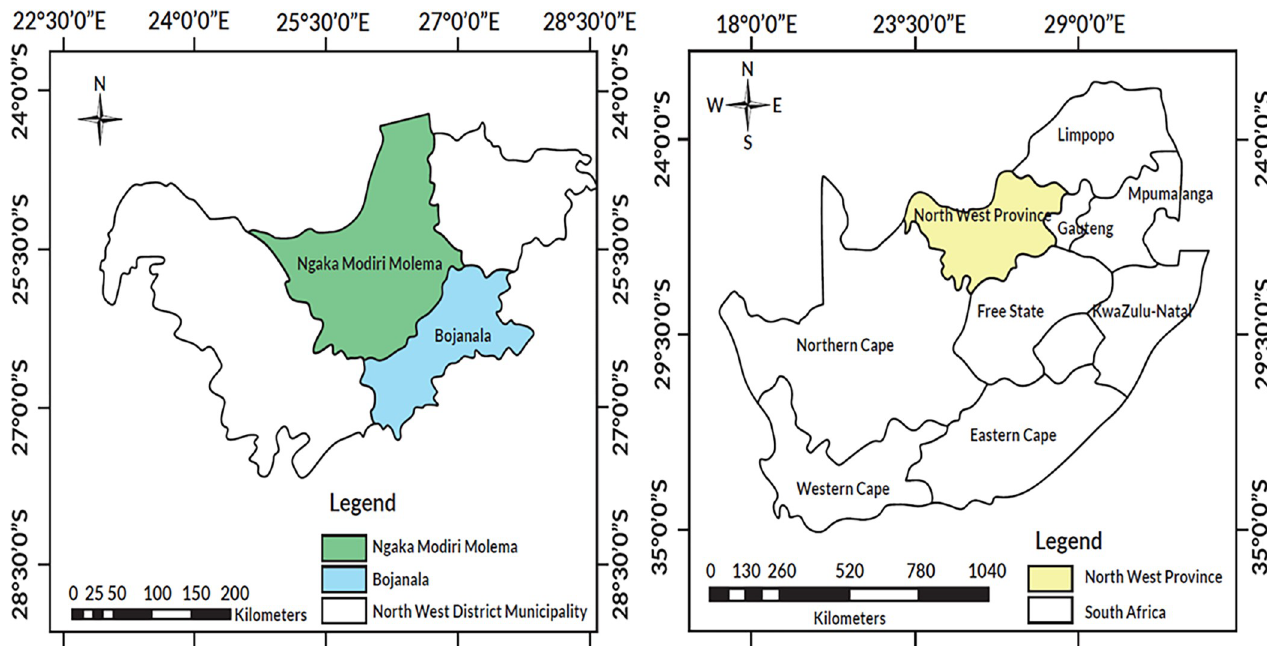
Fig 1. Selected district municipalities (Ngaka Modiri Molema and Bojanala) in the North West Province, South Africa. The map was prepared using the free software QGIS version 3.22.14 Bilowieza (available at: www.qgis.org). This figure is licensed under Creative Commons Attribution License (CCAL), CC BY 4.0.